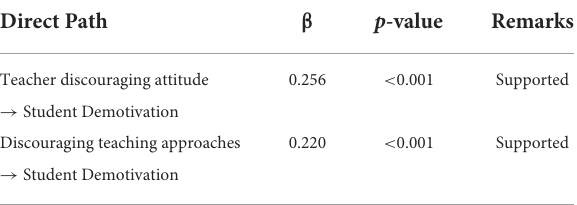
TABLE 5 Direct path coefficient and p